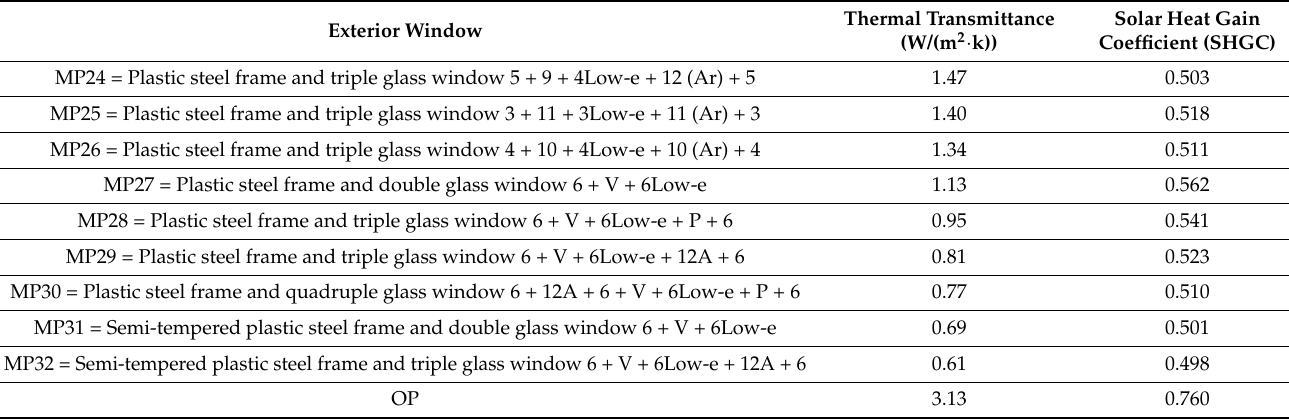
Table 4. Modification parameter design plan (MP)—Exterior window.